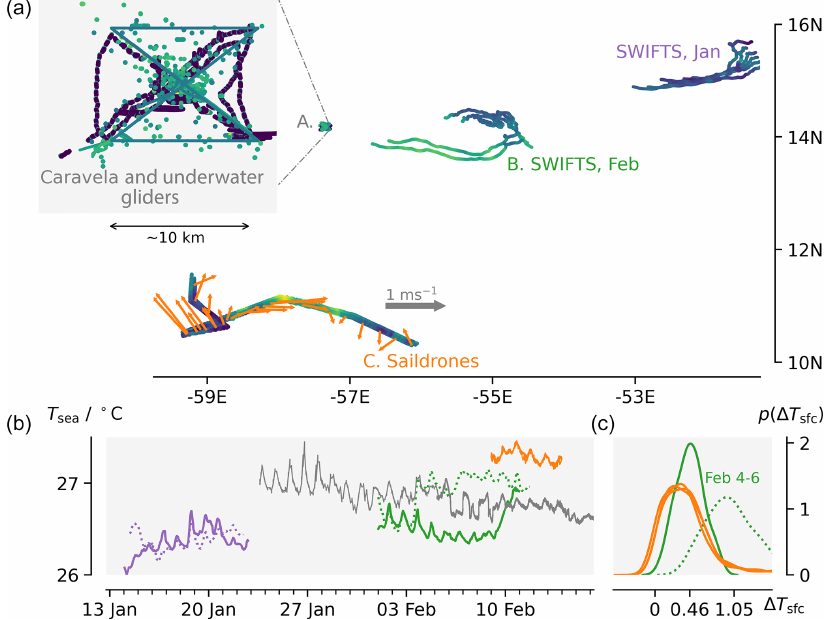
Figure 17. Near-surface temperature ( T sea ) from drifters and gliders in the three EUREC 4 A study regions. Panel (a) shows the tracks of the instruments colored by T sea . The magnification (upper left) expands the domain of the Caravela (and underwater glider) measurements in Region A (near 57 ◦ W). January and February SWIFT buoy ( T sea at − 0.3m) deployments in Region B. Saildrone ( T sea at − 0.5m) measurements across an eddy near 11 ◦ N, with anti-cyclonic currents (at − 5m) shown by vectors, in Region C. Panel (b) shows time series of T sea measurements by the different instruments. Probability density, p , of air–sea temperature differences measured by two SWIFT buoys between 04:00UTC 4 February and 14:00UTC 6 February (c)